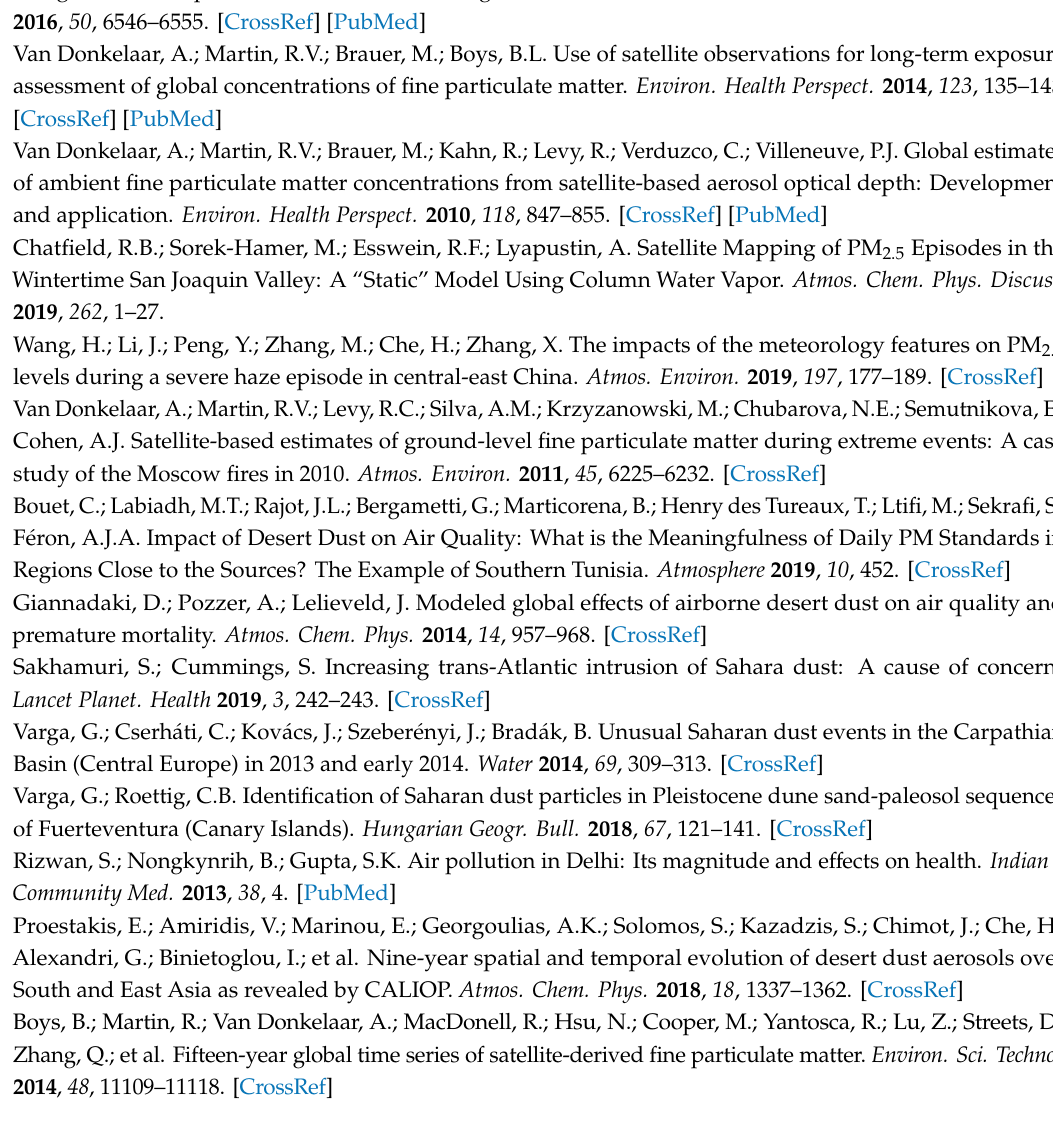
Table S1: Statistics of dependent and independent variables for each season and annually; Table S2: Statistics of dependent and independent variables for each